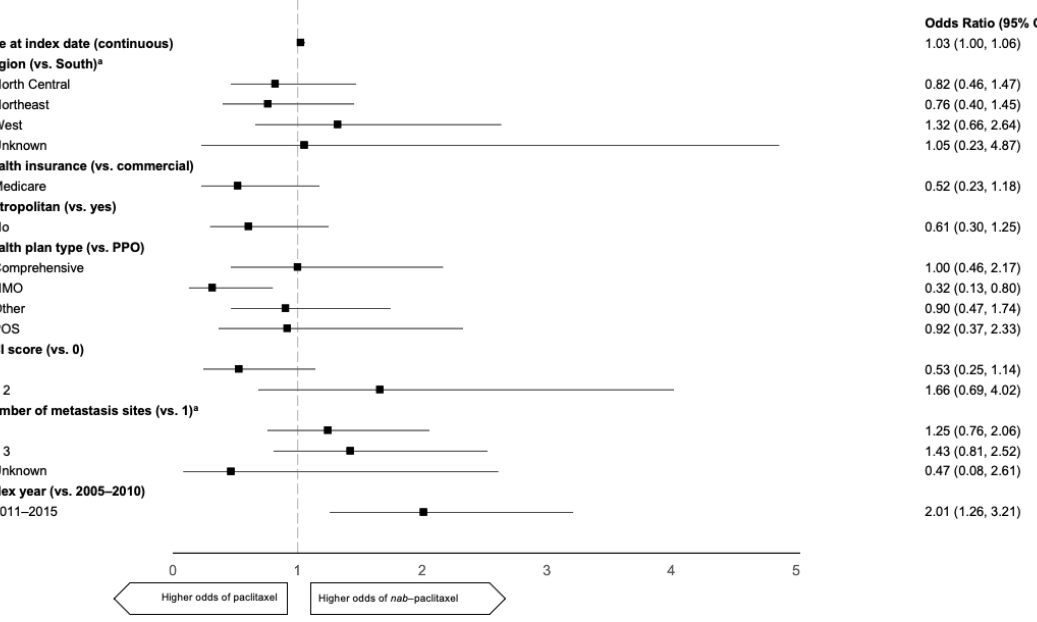
B: Nab -Paclitaxel versus docetaxel. Figure 3.